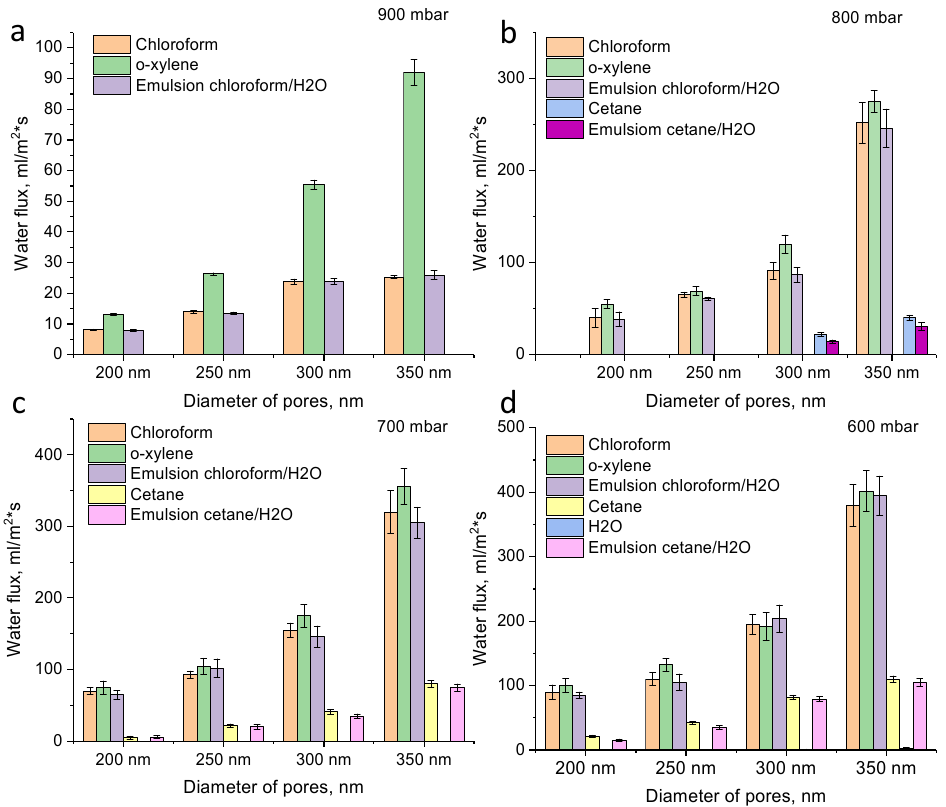
Figure 5. Fluxes of hydrophobic PET TeMs for chloroform, o-xylene, cetane and chloroform/water emulsion at different pore sizes (200, 250, 300 and 350 nm) and pressure 900 mbar ( a ), 800 mbar ( b ), 700 mbar ( c ) and 600 mbar ( d ).